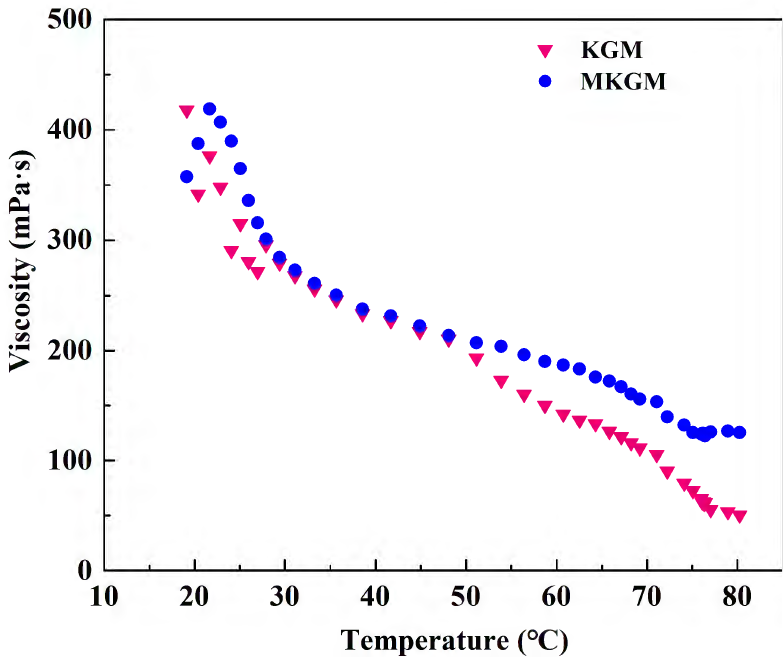
Figure 6. The effect of temperature on viscosity of KGM and MKGM